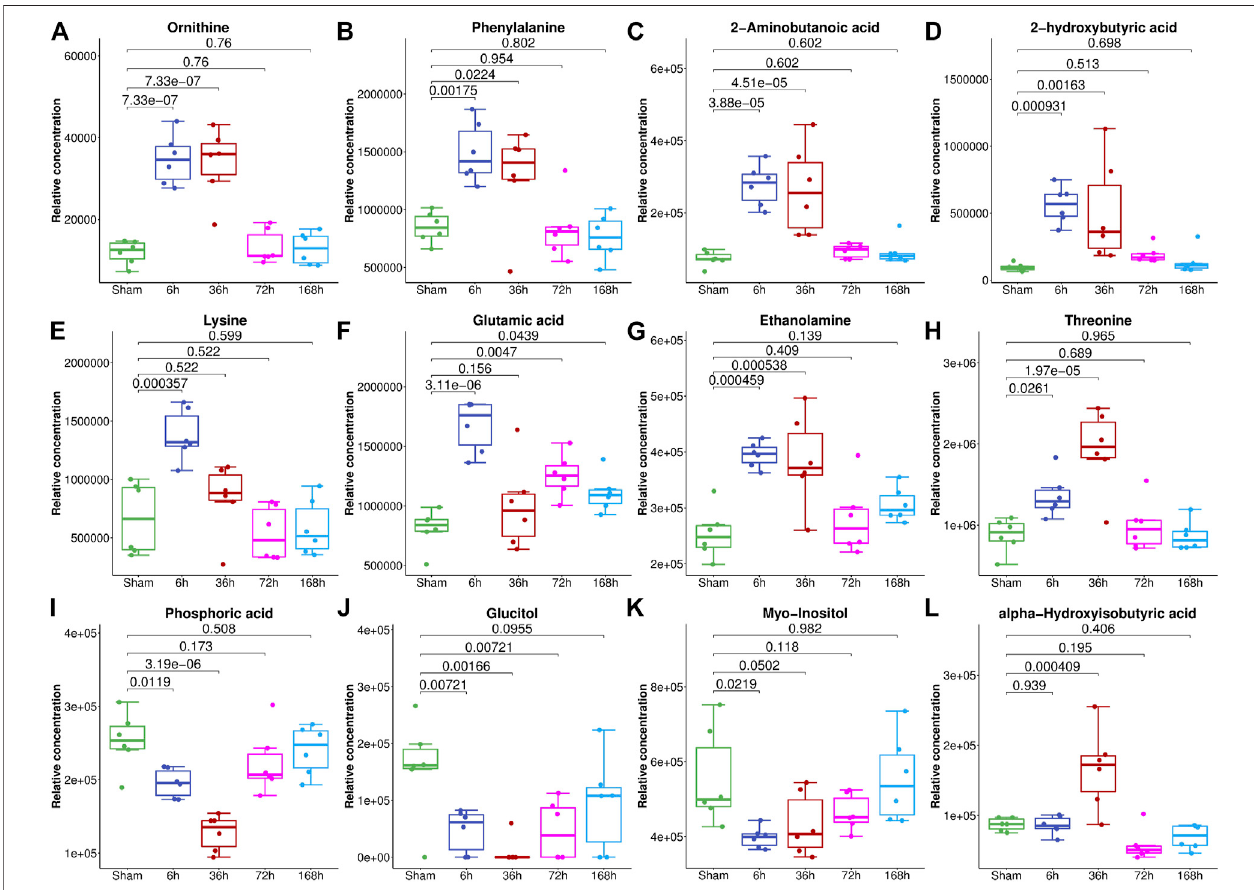
FIGURE 4 | The relative abundance of metabolites with the highest VIP values in the serum of mice from the Sham group and 6, 36, 72, and 168 h after PHx. The boxplotshowstherelativeabundanceofmetabolites,includingornithine (A) ,phenylalanine (B) ,2-aminobutanoicacid (C) ,2-hydroxybutyricacid (D) ,lysine (E) ,glutamic acid (F) , ethanolamine (G) , threonine (H) , phosphoric acid (I) , glucitol (J) , myo-inositol (K) and alpha-hydroxyisobutyric acid (L) . Data were represented as mean ±